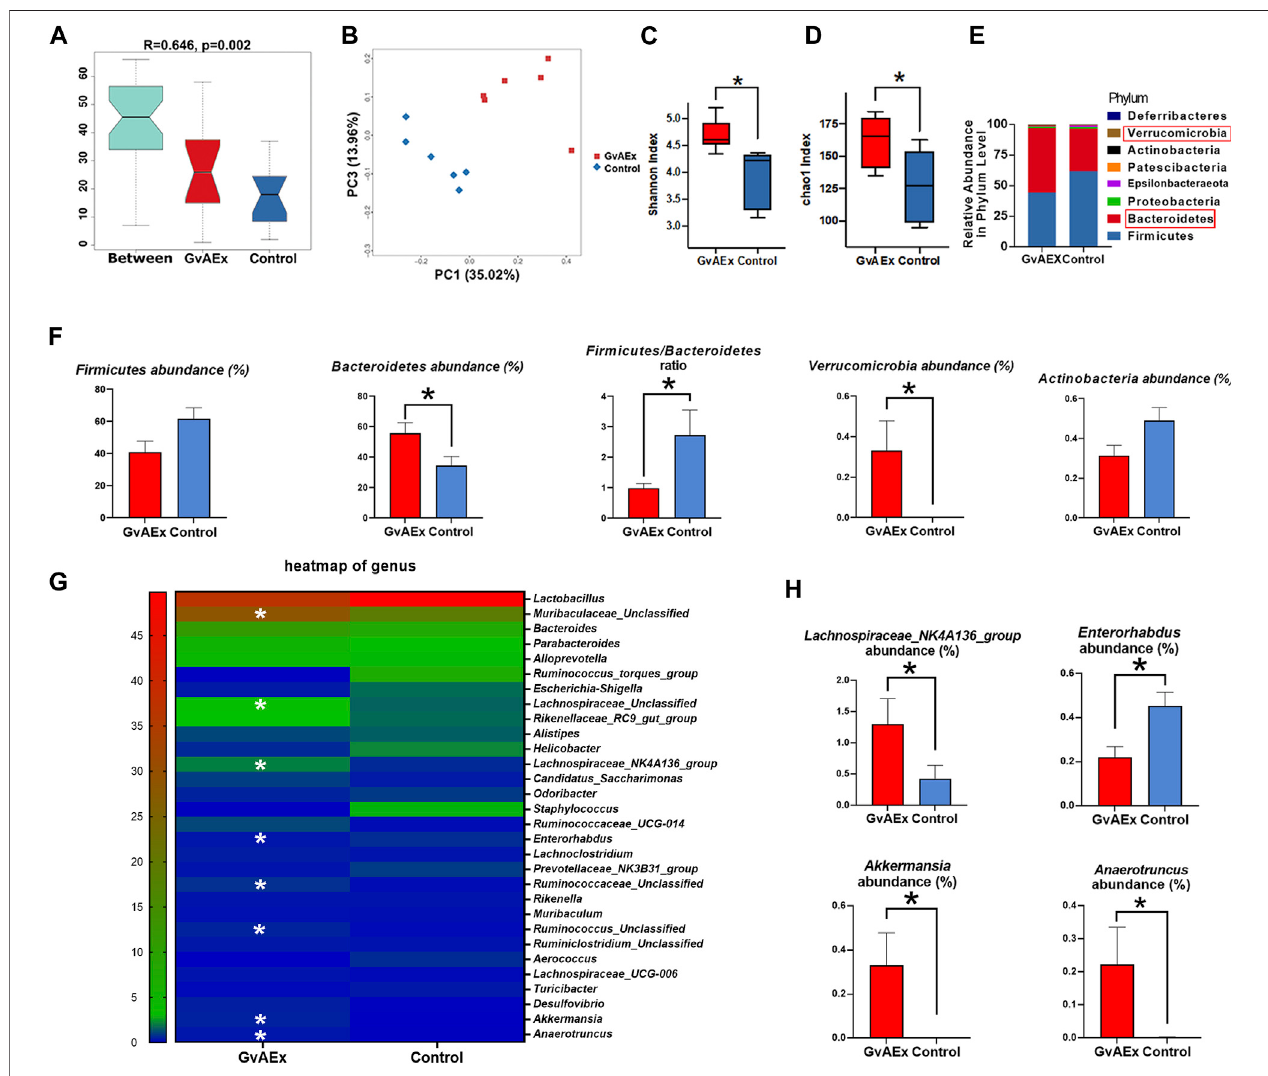
FIGURE 5 | GvAEx treatment alters the composition of gut microbiota in db/db mice. ( A) Anosim analysis of gut microbiota in db/db mice treated with GvAEx or vehicle for 12 weeks ( R = 0.646, p = 0.002) ( n = 6/group). (B) PCOA of gut microbiota in mice based on weighted UniFrac. (C) Species diversity indices (Shannon). (D) Species richness estimates (Chao1). (E) Phylum level comparison of gut microbiota proportional abundance in feces of GvAEx and control. (F) Relative abundance of microbiotaphylumbetweenthegroups. (G) Heatmap ofgutmicrobiotaatthegenus levelinmice. (H) Relativeabundanceofmicrobiota atthegenuslevelbetween groups. * p <